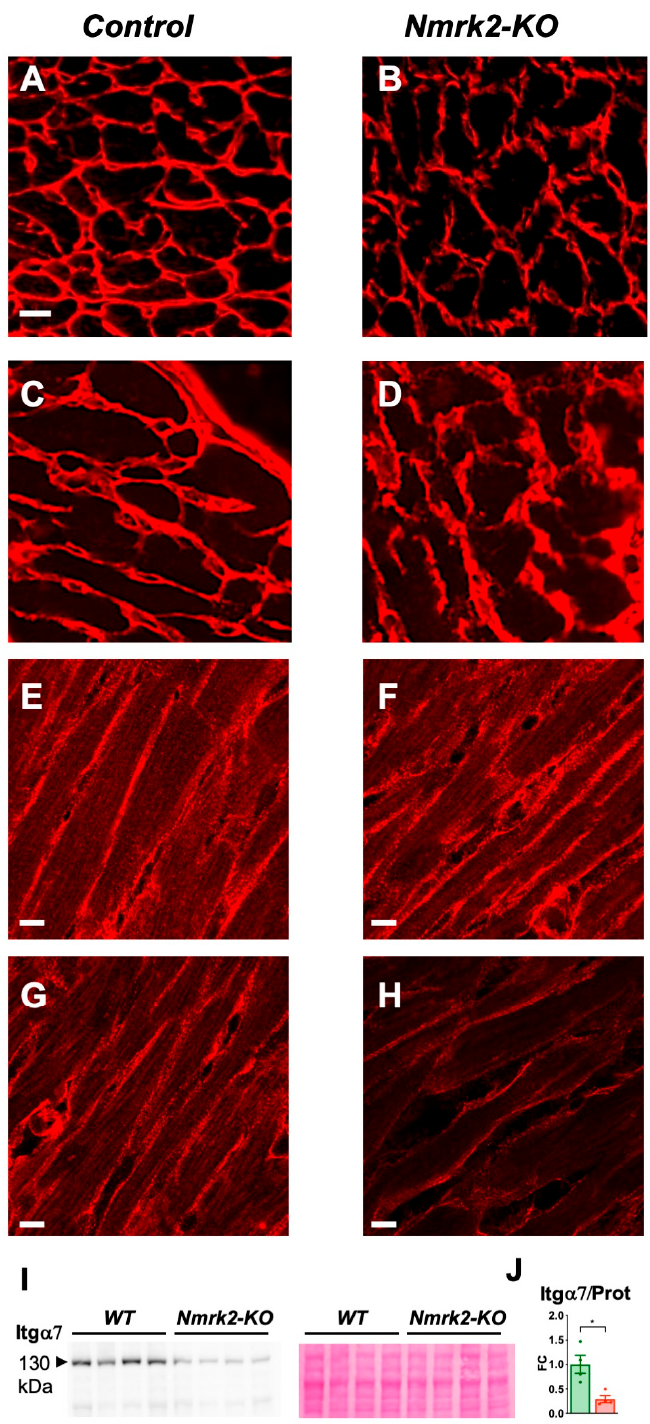
Figure 6. Laminin and integrin α 7 pattern in Nmrk2-KO myocardium. ( A – D ) Laminin α 2 staining in frozen heart sections from control and Nmrk2-KO mice at the age of 4 months ( A , B ) and 24 months ( C , D ). ( E – H ) Integrin α 7 staining from control and Nmrk2-KO mice at the age of 4 months ( E , F ) and 24 months ( G , H ). White bars = 10 µ M. Pictures are representative of n = 3 mice/group. ( I ) Western blot showing integrin α 7 expression in the heart of control and Nmrk2-KO mice at 24 months. Red Ponceau staining on the right panel was used for loading control. ( J ) Quantification of western blot. Individual data are plotted ( n = 4/group). Bar graph represents de fold change over mean control value and error bars the SEM. t-test: *, p <